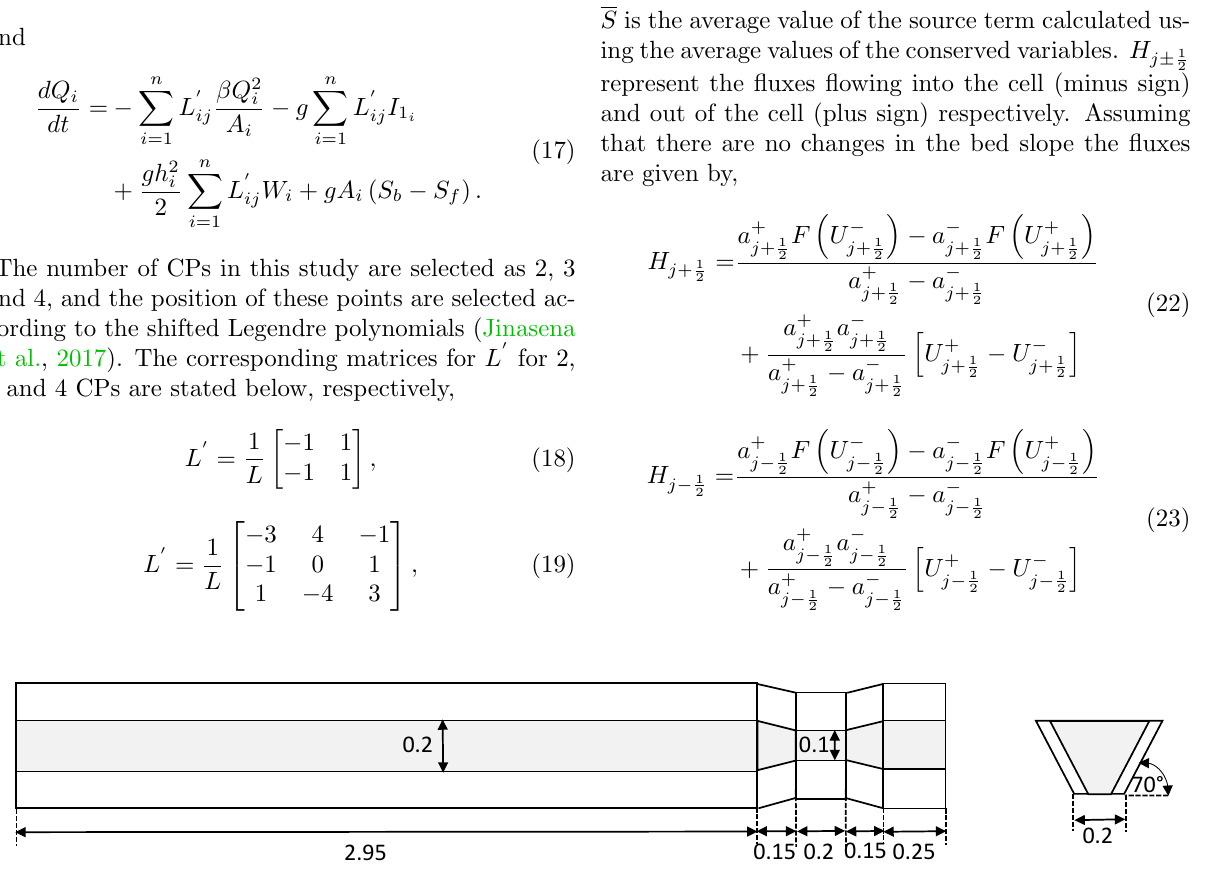
Figure 2: The sketch of the used Venturi channel (measurements are given in meters)